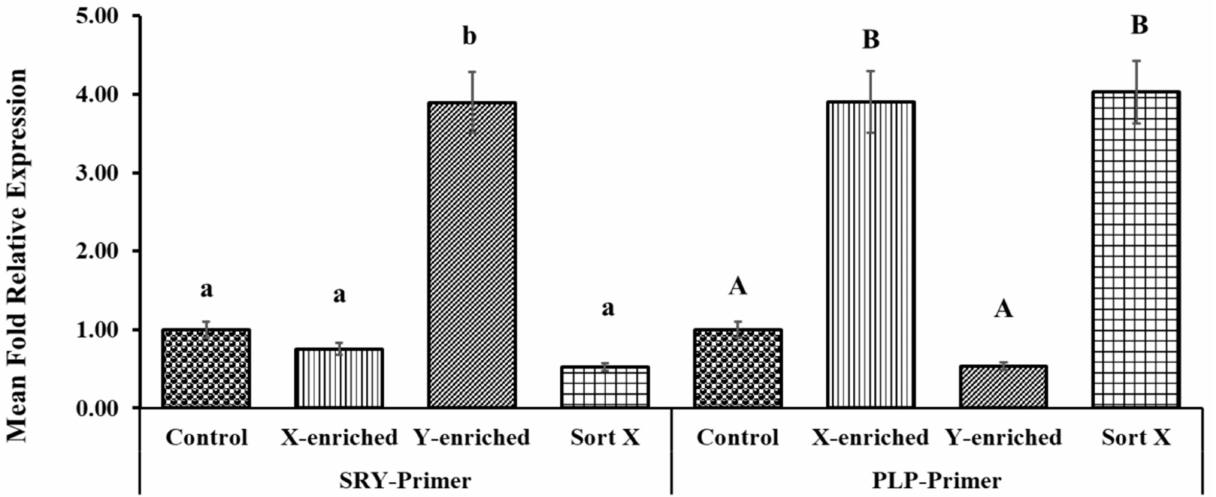
Figure 7. Expression levels of PLP and SRY genes in X- and Y-enriched semen samples were measured by RT–PCR to validate the sexing technique for bull semen. Con: conventional frozen–thawed semen; X-enriched: fraction of sperm not bound by PY-magnetic beads; Y-enriched: fraction of sperm entrapped by PY-magnetic beads; Sort X: commercial cell-sorter-sexed semen; A, B = comparison of PLP amplicons from each group; a, b = comparison of SRY amplicons from each